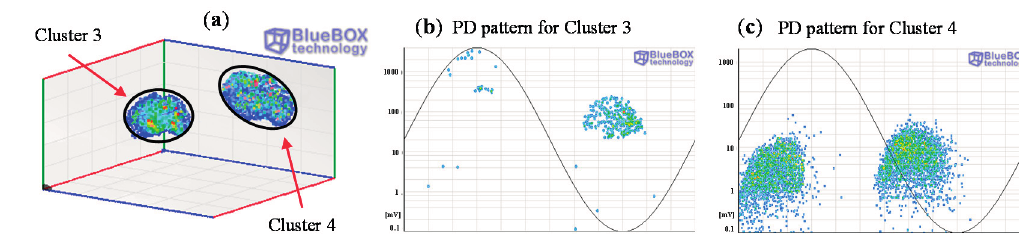
Figure 23. ( a ) Classification of PD pulses positioned in C, ( b ) and ( c ) PRPD patterns for the sources positioned in C.